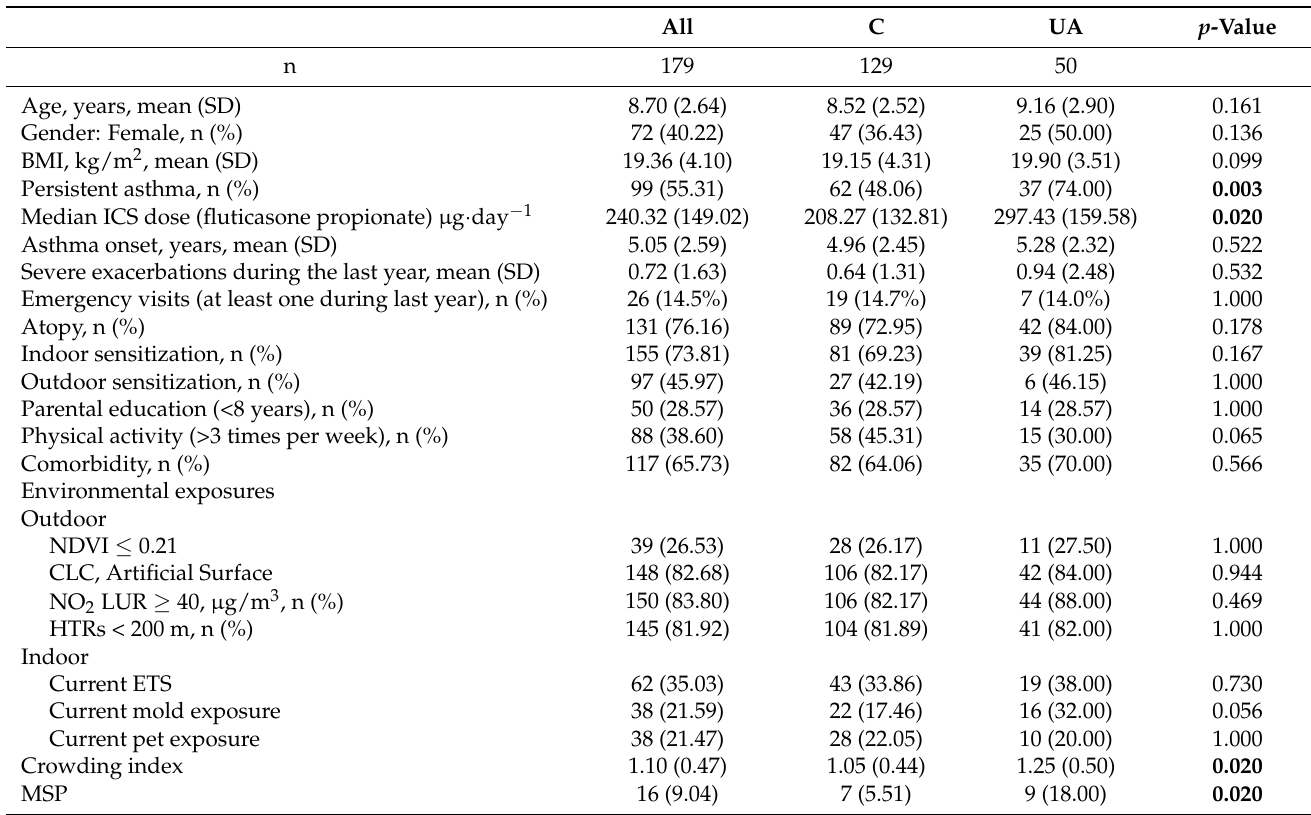
Table 1. Demographic characteristics by asthma control status at baseline.